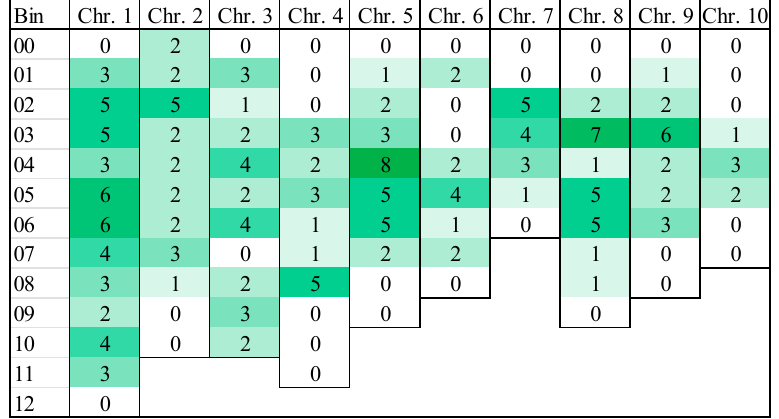
Figure 2. Number of QTLs for resistance to NCLB according to the literature; the intensity of color represents the number of QTLs found in the same bin (for details please refer to supplementary material).